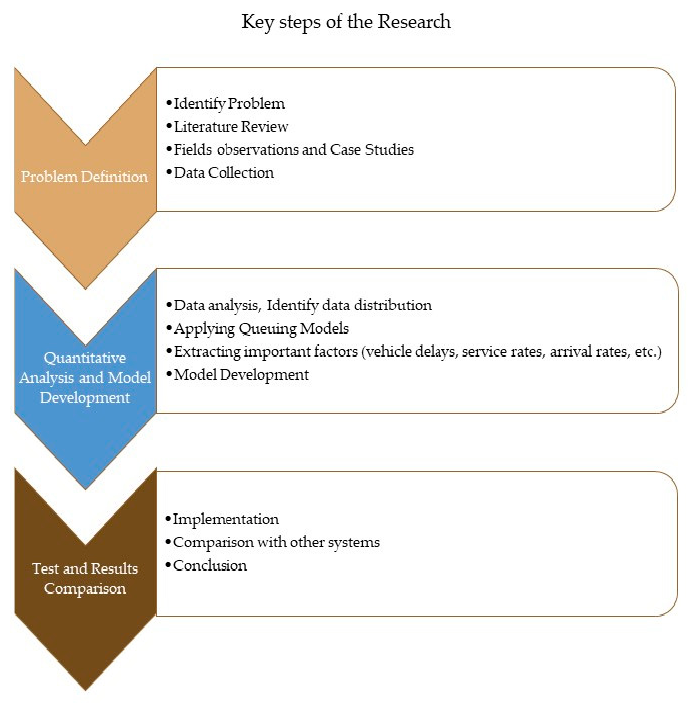
Figure 1. Key steps of the research methodology .